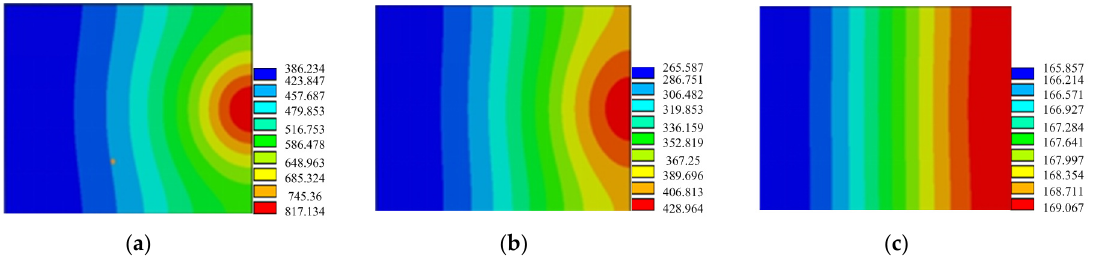
Figure 8. Temperature contour of the plane without cracks in the cooling process (40 < t < 180 s). ( a ) t = 50 s; ( b ) t = 80 s; ( c ) t = 100 s.